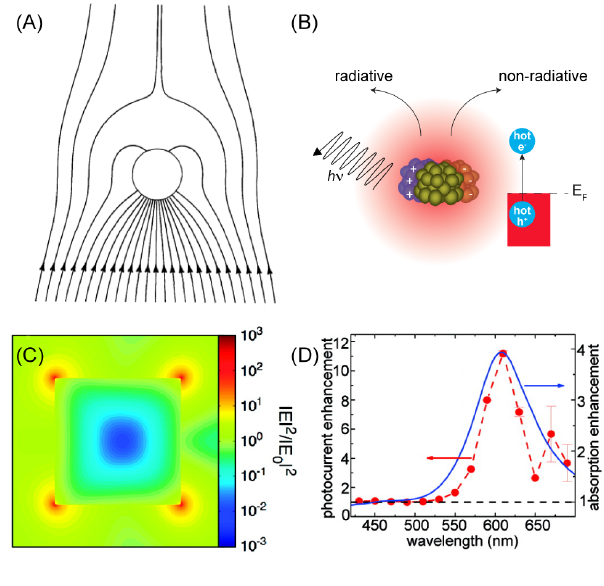
Figure 1: Light-matter interaction at the nanoscale: (A) Poynting vectors excluding scattering effects for an Al sphere excited by an incident electromagnetic wave with an electric field in the plane of the image. (B) Surface plasmon decay mechanisms: radiative (scattering) and non-radiative. (C) Field enhancement at 450 nm from a finite difference time domain (FDTD) simulation of a 120-nm Ag cube in water. (D) Measured photocurrent (red symbols) and simulated (solid blue line) absorption enhancement spectra that show their overlap as a signature of the plasmonic enhancement in Au/ α -Fe 2 O 3 photoelectrodes. Figures (A), (C) and (D) adapted with permission from references [40, 46] and [86], respectively. (A): Copyright (1983), American Association of Physics Teachers. (C,D): Copyright (2011) American Chemical